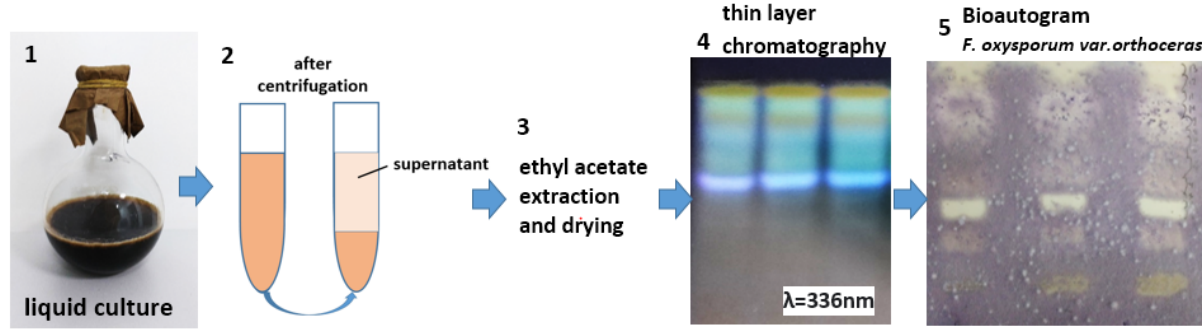
Figure 2. Main stages of the study of composition and quantity of bacterial metabolites.